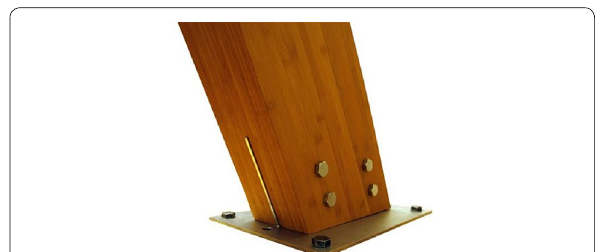
Fig. 1 Bolted timber joints with slotted-in steel plates